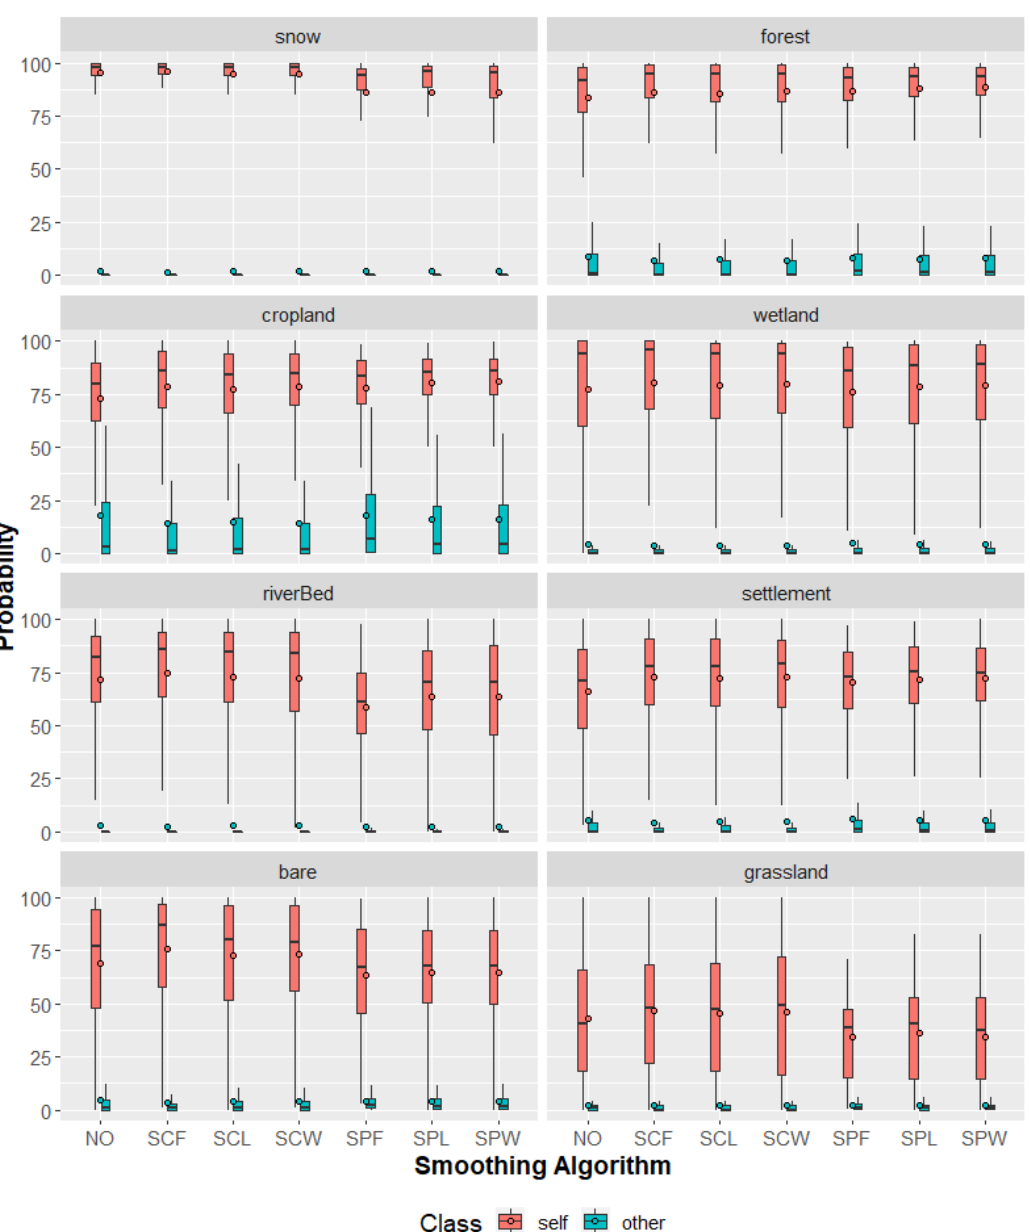
Figure 4. Assessment of primitives prepared using different algorithms. NO = No smoothing applied, SCF = Fourier smoothing applied on composite, SCL = Linear-fit smoothing applied on composite, SCW = Whittaker smoothing applied on composite, SPF = Fourier smoothing applied on primitive, SPL = Linear-fit smoothing applied on primitive, SPW = Whittaker smoothing applied on primitive. The distance between red and blue box plots in the vertical axis shows the inter-class separability of a